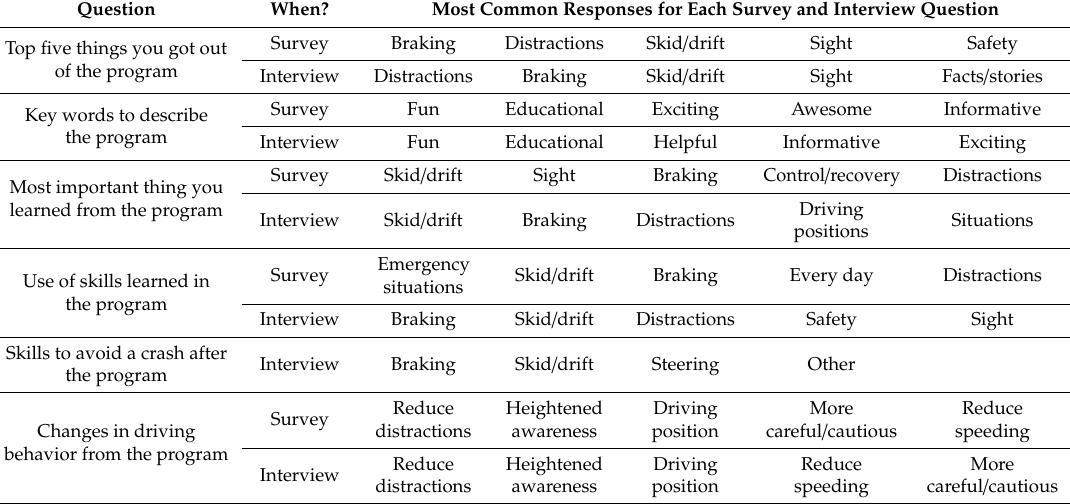
Table 2. Summary of the five most common responses for questions on the survey, which took place immediately after the program, and the interview, which took place approximately three months